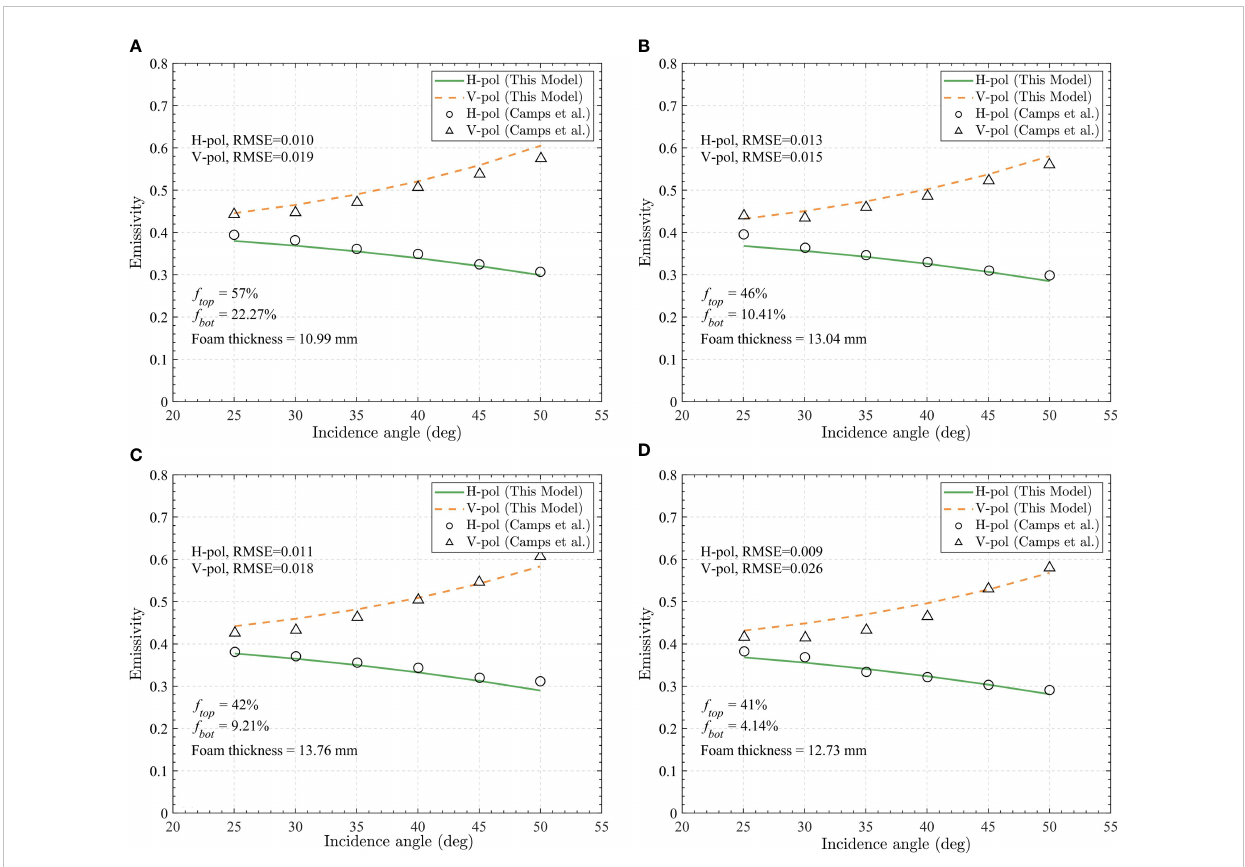
FIGURE 6 Comparison of the foam emissivity calculated with the present model to the experimental data (Camps et al., 2005, symbols) with different water properties: (A) temperature T s = 20.6°C salinity S s = 10.49 psu; (B) temperature T s =18.4°C salinity S s = 16.29 psu; (C) temperature T s =18.8°C, salinity S s = 25.5 psu; (D) temperature T s =15.6°C, salinity S s = 37.33